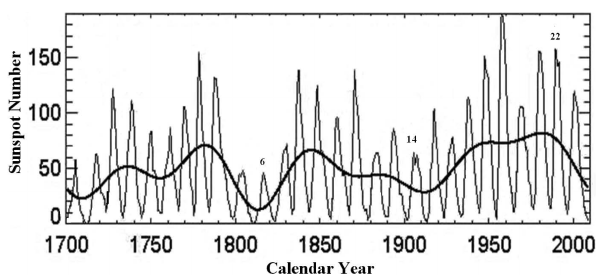
Fig. 6. The annual mean sunspot numbers (thin solid line) and their smoothed values (thick solid line) from 1700 to